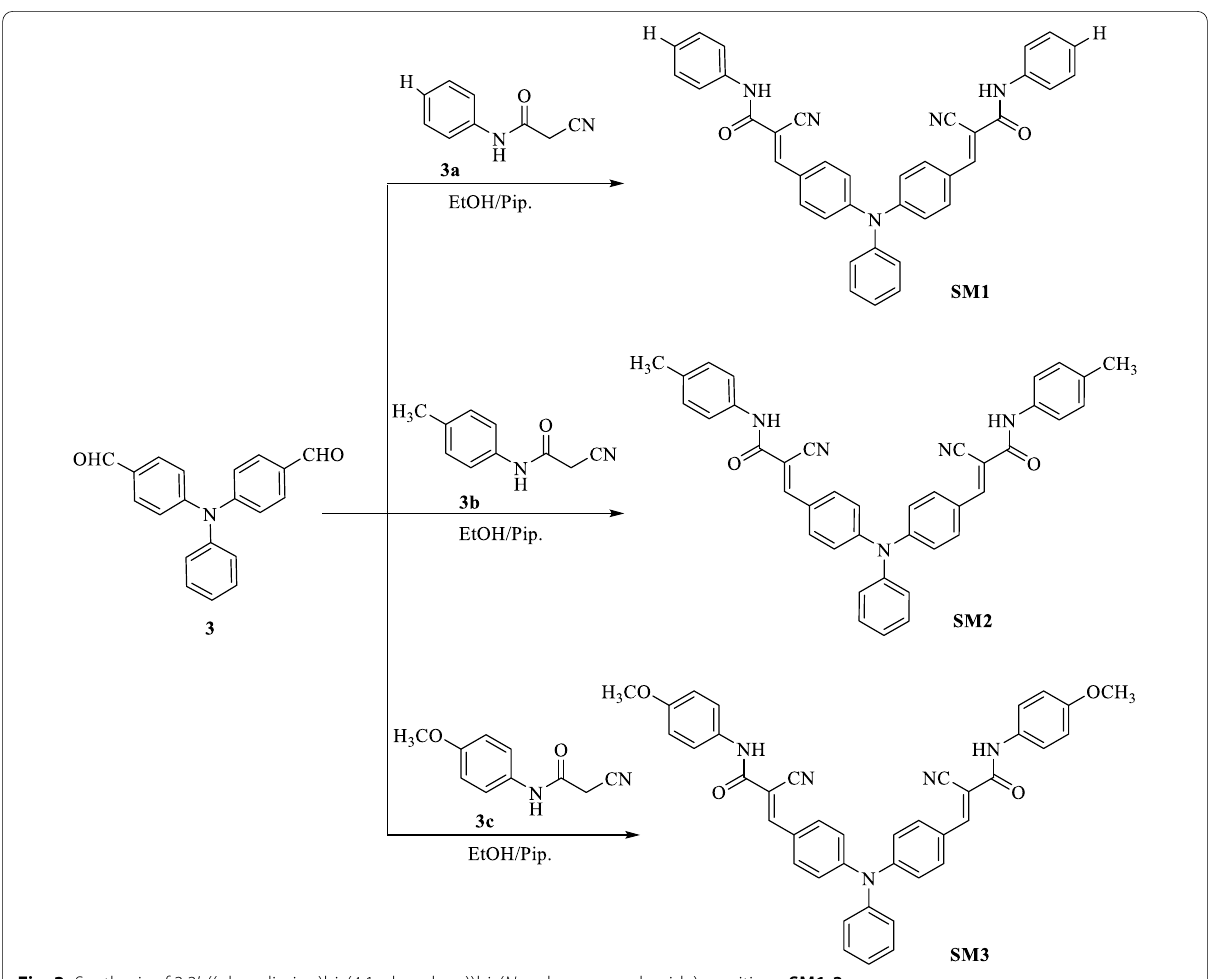
Fig. 3 Synthesis of 3,3’‑((phenylimino)bis(4,1‑phenylene))bis( N ‑aryl‑cyanoacrylamide) sensitizers